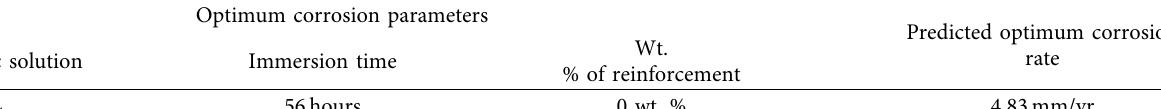
Table 6: Optimum corrosion parameters and their optimum value.